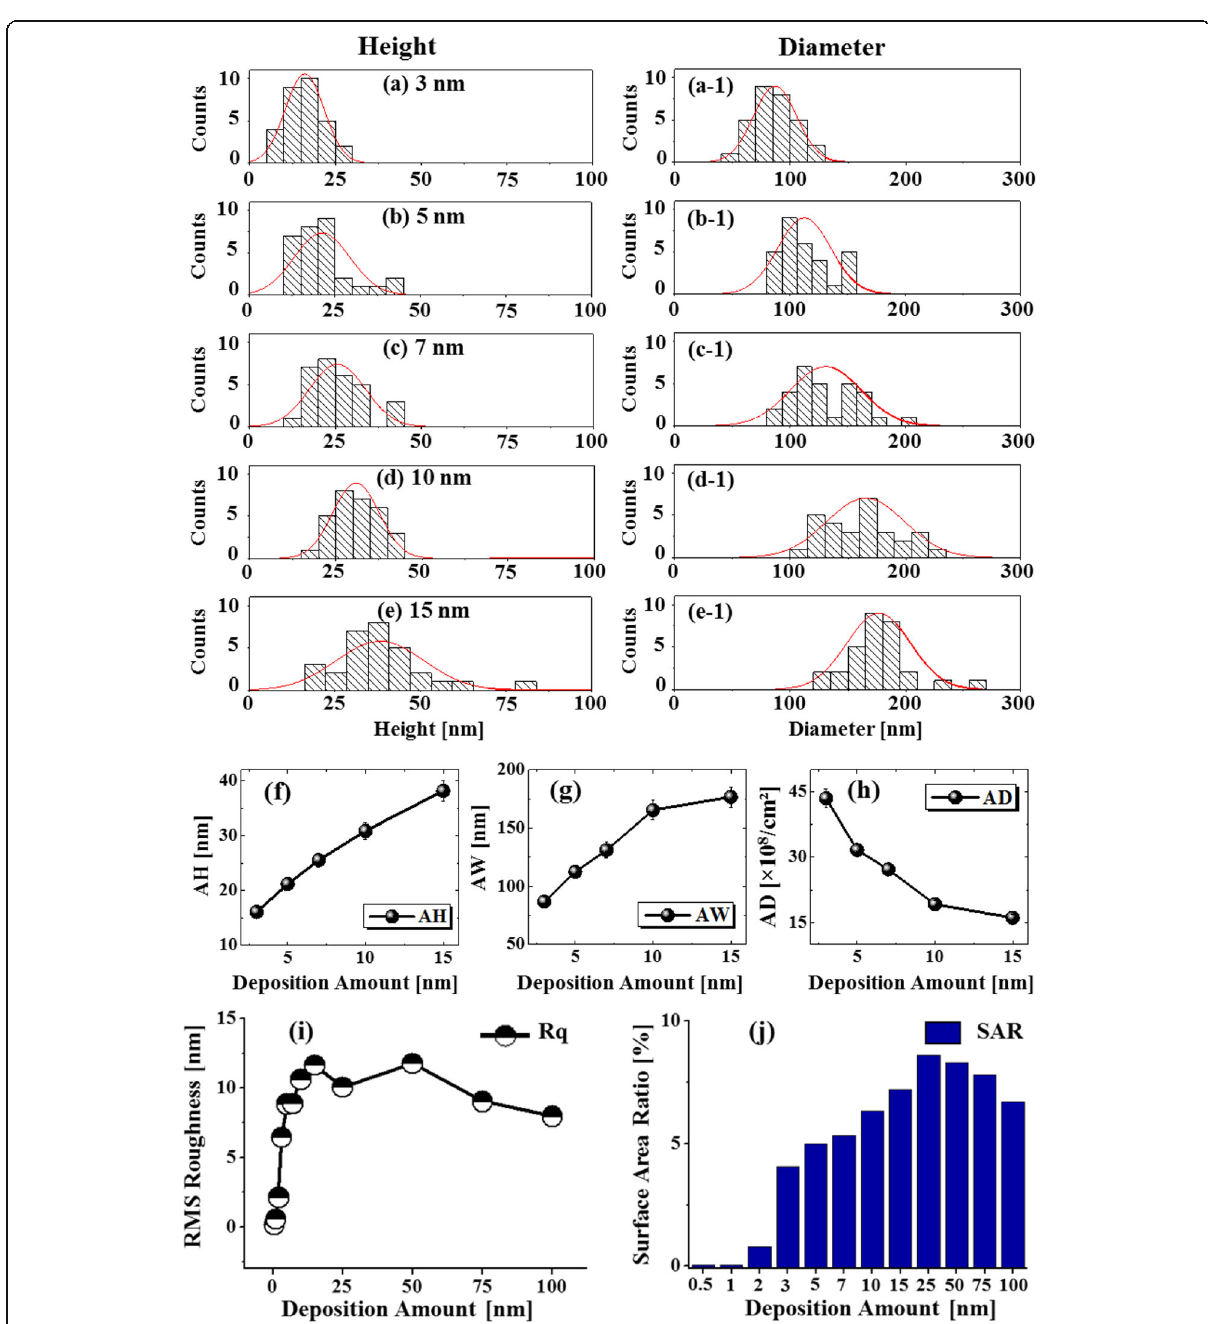
Fig. 2 Height in a – e and diameter in a-1 – e-1 distribution histograms of Pd NPs with 3 to 15 nm deposition amount annealed at 575 °C for 450 s. f – h Summary of average height ( AH ), average width ( AW ), and average density ( AD ) with respect to the deposition amount. Error bars for the AH , AW , and AD are ±5% in f , g , and h. i , j . Summary plots of RMS roughness ( Rq ) and surface area ratio ( SAR